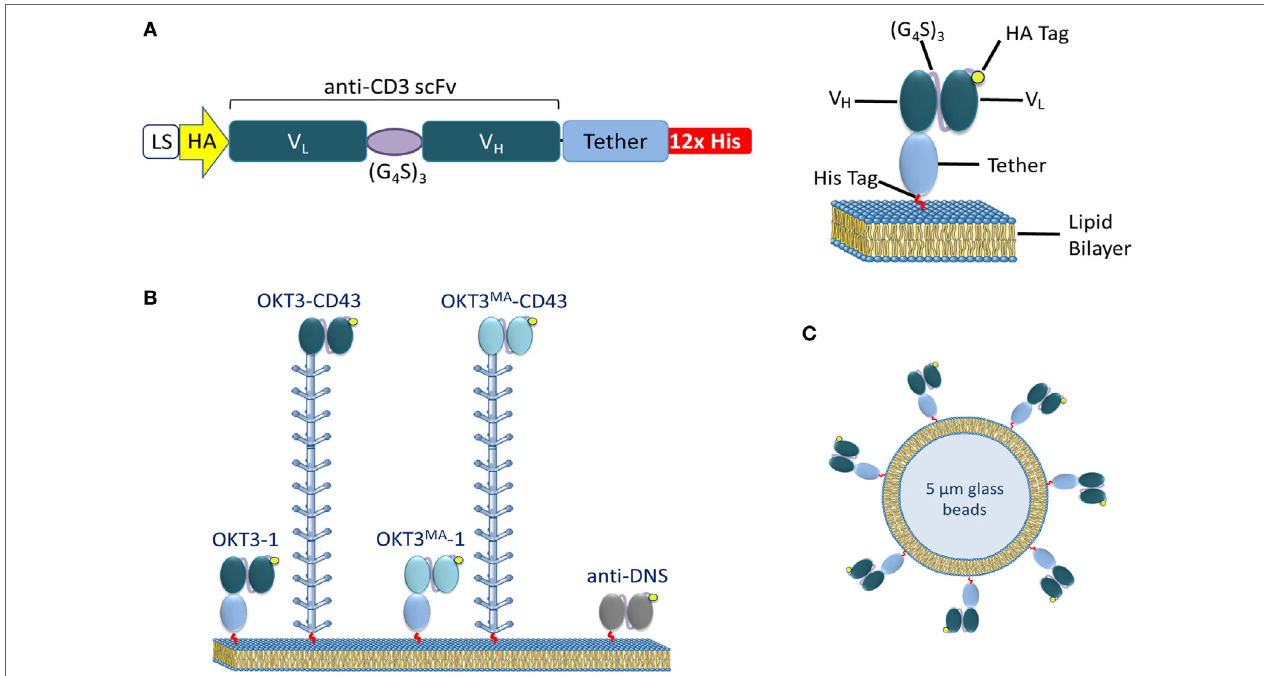
FigUre 1 | Lipid membrane-tethered anti-CD3 antibodies. (a) Left: a retroviral cassette expressing soluble anti-CD3 scFv. The cassette includes an IgG κ leader sequence, a sequence coding for an HA tag, the anti-CD3 scFv V L and V H regions connected by a GS linker (G 4 S) 3 , followed by a short or long tether and 12 × His tag. Right: a schematic drawing of the scFv attached to a lipid bilayer by Ni-His affinity interactions. (B) A schematic drawing of the ligands used: OKT3 or OKT3 MA scFv elongated by an immunoglobulin-like domain (BGP) or the CD43 ectodomain. (c) A schematic drawing of artificial APCs formed from 5 µm glass beads coated with a lipid bilayer decorated with anti-CD3